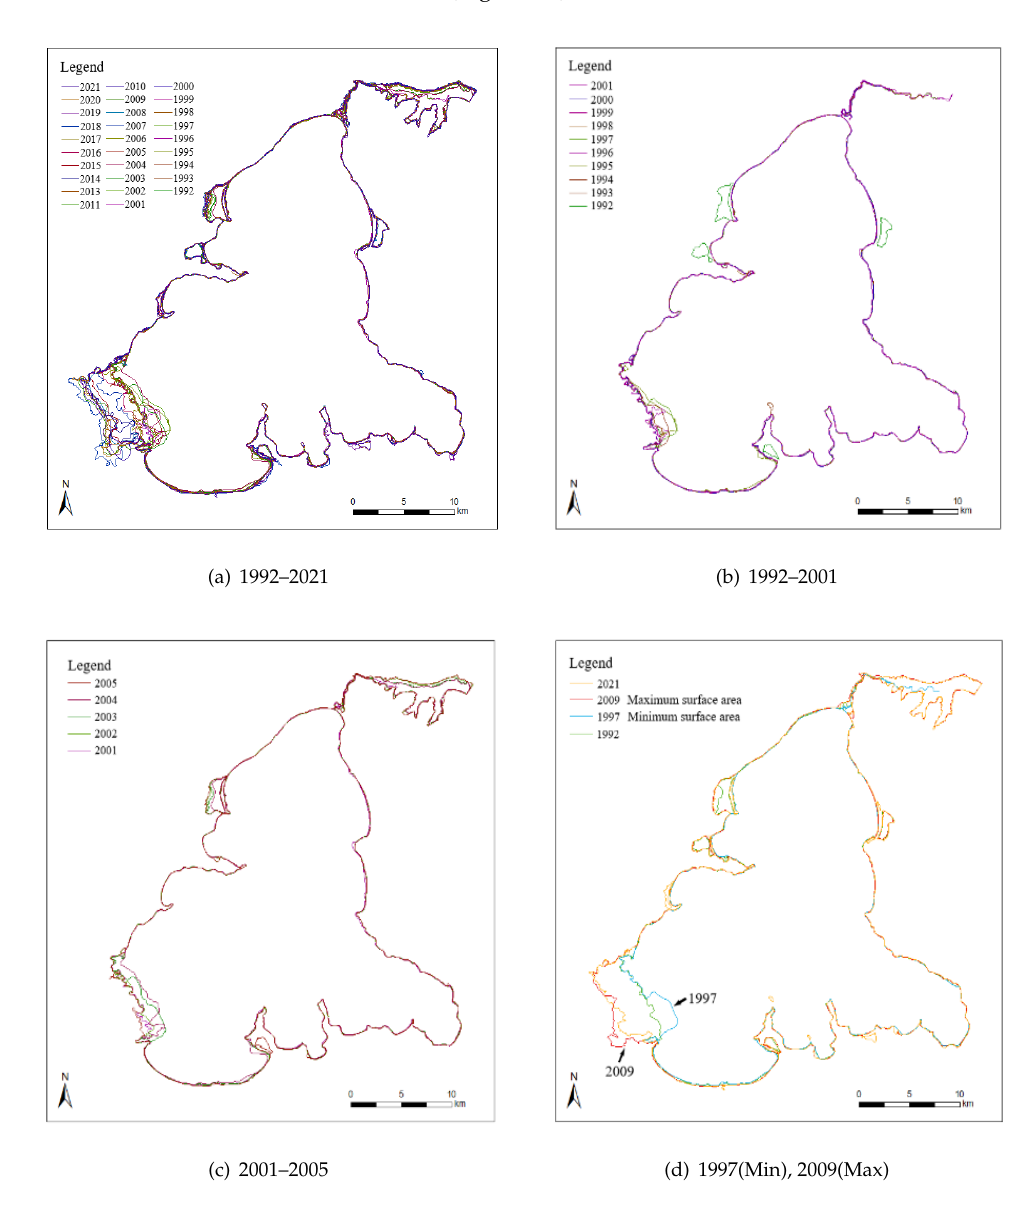
Figure 10. Shoreline changes of Ngoring Lake during the period